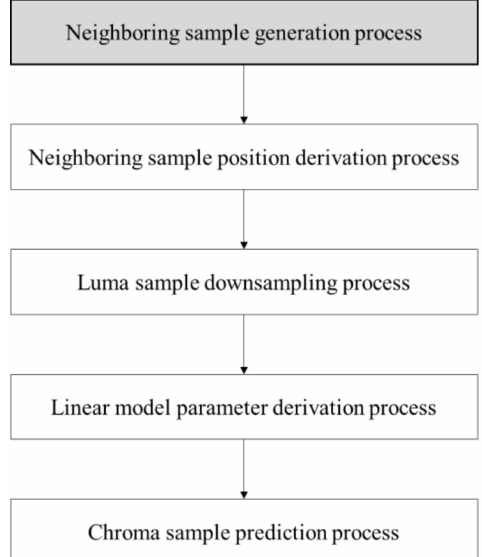
Figure 6. Processing flow chart of the proposed